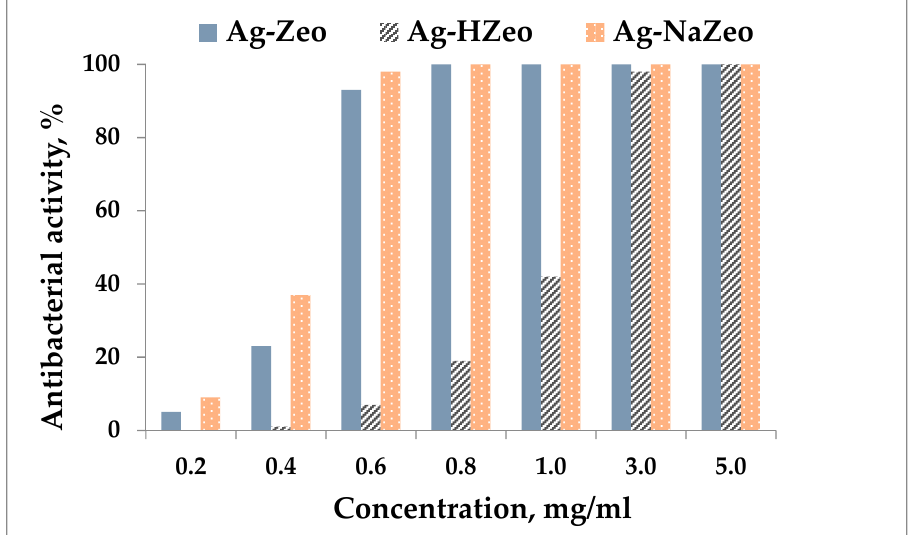
Figure 6. Antibacterial activity against Escherichia coli of samples Ag–Zeo, Ag–NaZeo, Ag–HZeo.